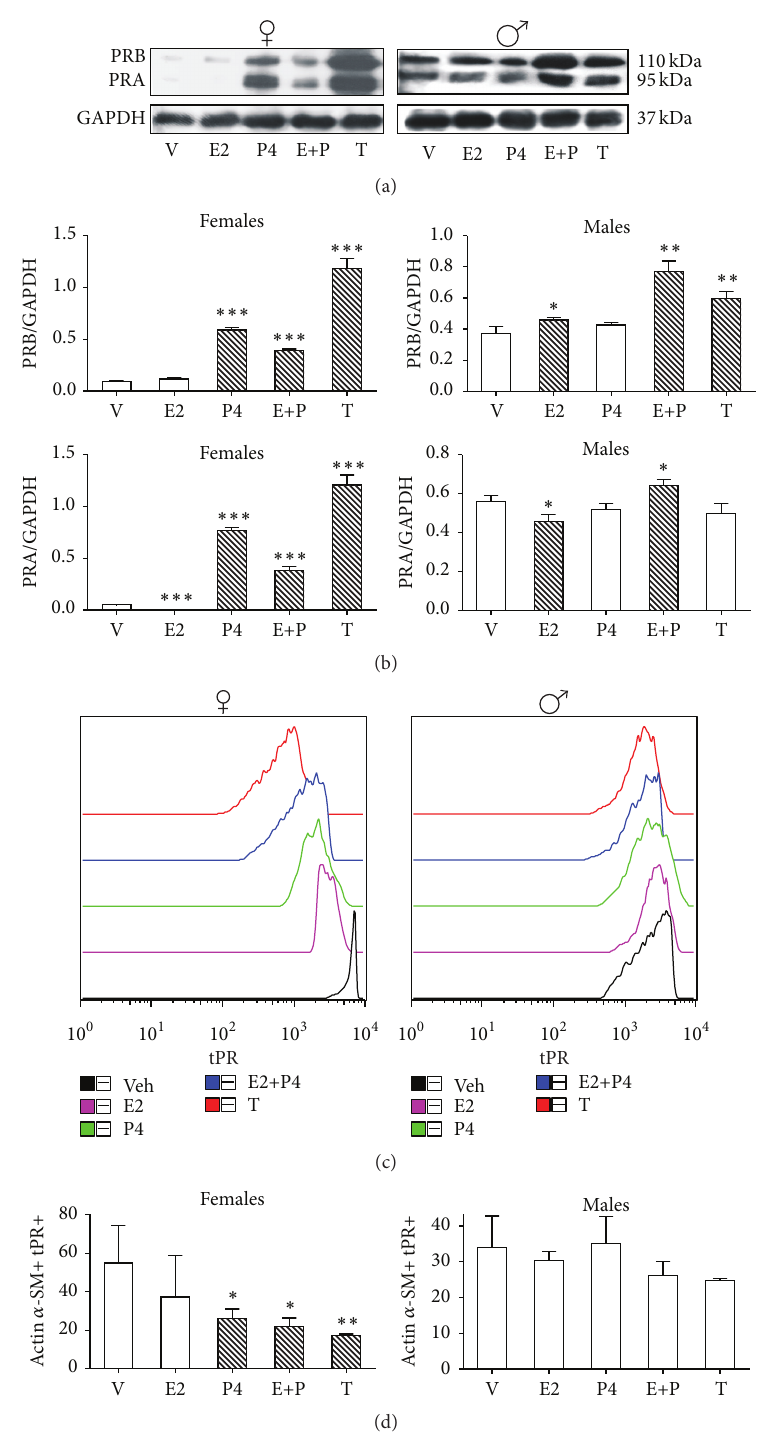
Figure 3: Regulation of PR isoforms protein content by sex hormones in airway smooth muscle (ASM) and airway smooth muscle cells (ASMC). PR isoforms protein content in ASM and total PR (tPR) in ASMC of gonadectomized female and male rats were treated as described in Figure 1 legend. (a) A representative assay of four Western blot experiments is shown (details are described in Figure 1 legend). (b) Proteins detected by Western blot were quantified by densitometric analysis and corrected by GAPDH protein content. Results are expressed as mean ± SD, 𝑛 = 4 . ∗ 𝑝 < 0.05 compared with vehicle treatment, ∗∗ 𝑝 < 0.01 compared with vehicle treatment, and ∗∗∗ 𝑝 < 0.001 compared with vehicle treatment. (c) Flow cytometry histogram plots are based on forward scatter (FSC) and side scatter (SSC) gating for ASMC. This was validated using actin 𝛼 -smooth muscle and both isoforms of PR (tPR) staining. A representative example of the gating strategy is shown. (d) Geometric mean fluorescence intensity (gMFI) for tPR expression on ASMC. Results are expressed as mean ± SD, 𝑛 = 4 . ∗ 𝑝 < 0.05 compared with vehicle treatment and ∗∗ 𝑝 < 0.01 compared with vehicle